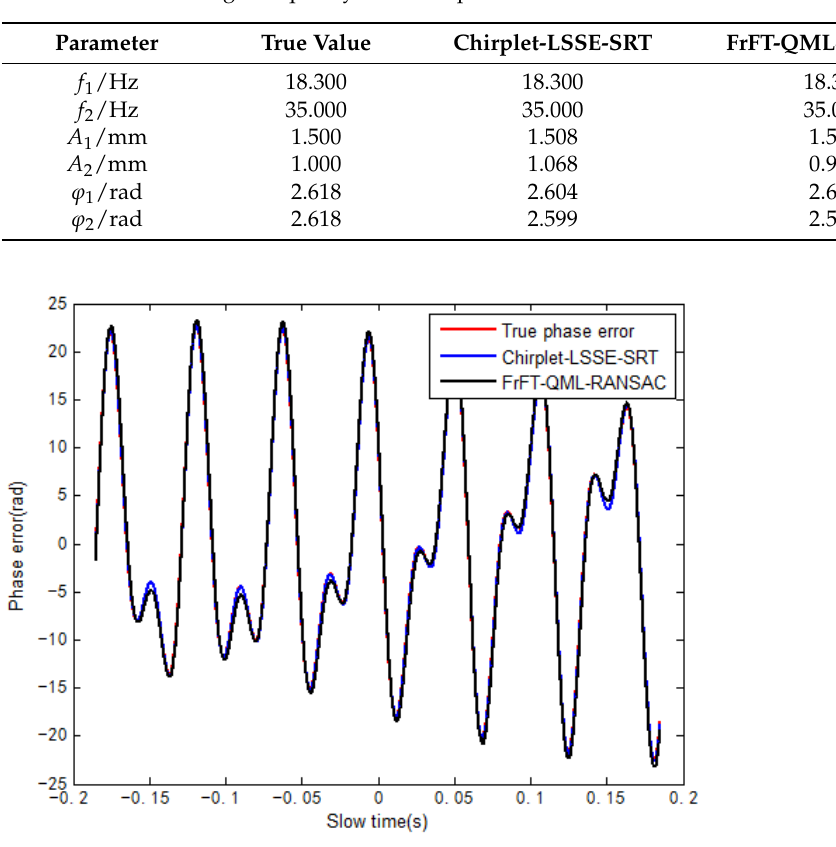
Table 3. Estimate of high-frequency vibration parameters.